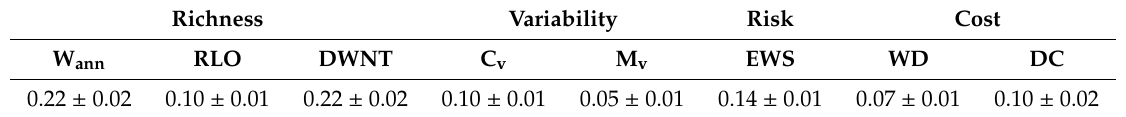
Table 4. Weight coe ffi cient in the wind energy classification. The standard deviation was calculated (cid:113) (cid:12) (cid:12) (cid:80) N 2 (cid:12) (cid:12) / N , where A is the weight coe ffi cient, A is the mean value of A and N is the as σ = (cid:12) A i − A (cid:12) i = 1 number of experts (10) consulted in